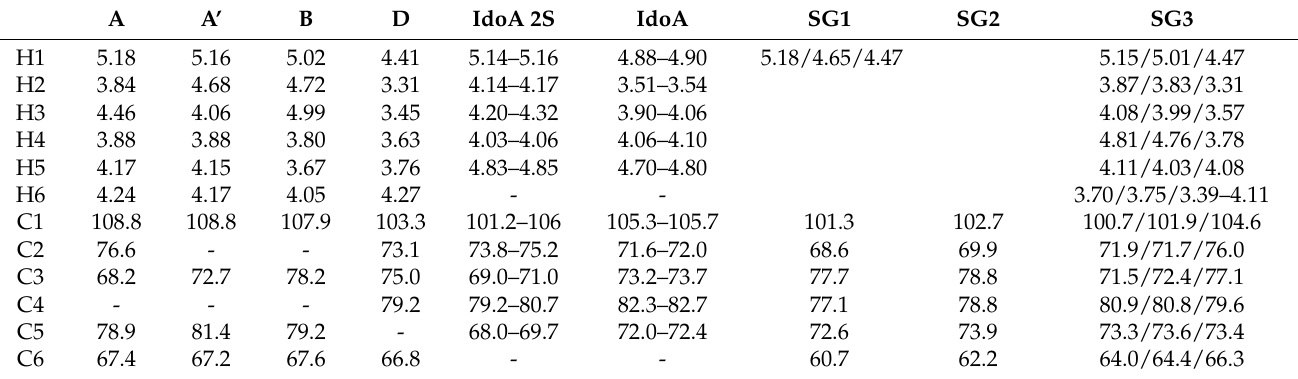
Table 4. Chemical shifts (ppm) of 1 H and 13 C NMR signals of residues A/A’, B, and D compared to literature values for sulfated galactans isolated from the tunic of different species of ascidians (SG1: Clavelina sp. [21]; SG2: H. monus [52]; SG3: M. exasperatus [22]) and iduronic acid from the flesh of different species of ascidians [23] (IdoA: α -L-iduronic acid; IdoA 2S: α -L-iduronic acid sulfated on